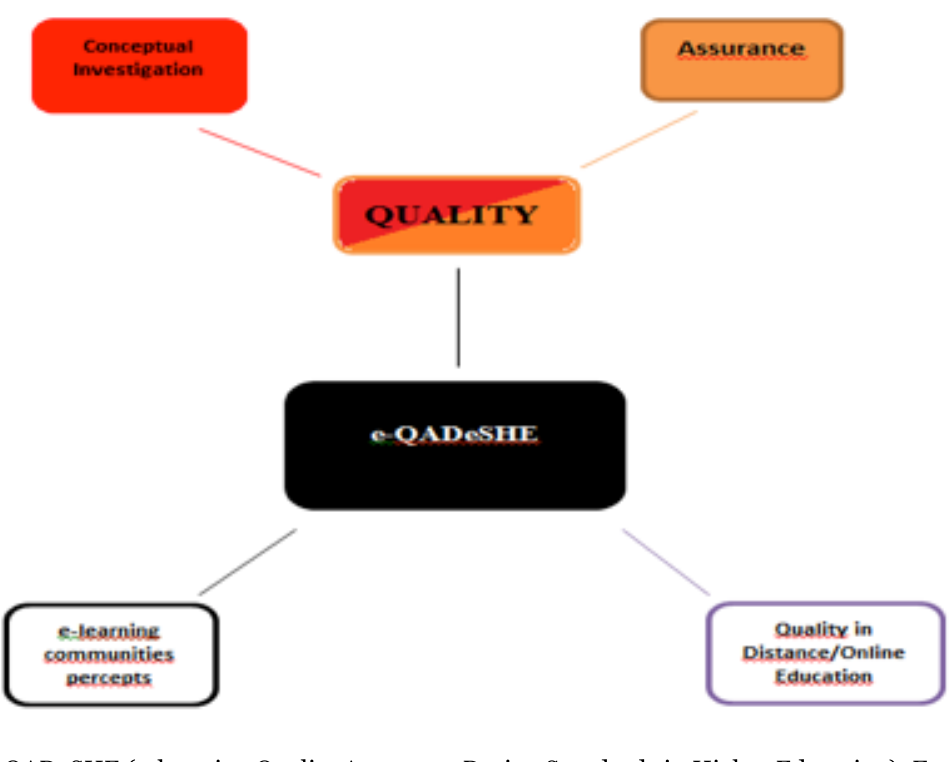
Figure 1. e-QADeSHE (e-learning Quality Assurance Design Standards in Higher Education): Focal Areas. Our outline of focal areas of interest for QA design and implementation in HE after the extended integration of distance and online